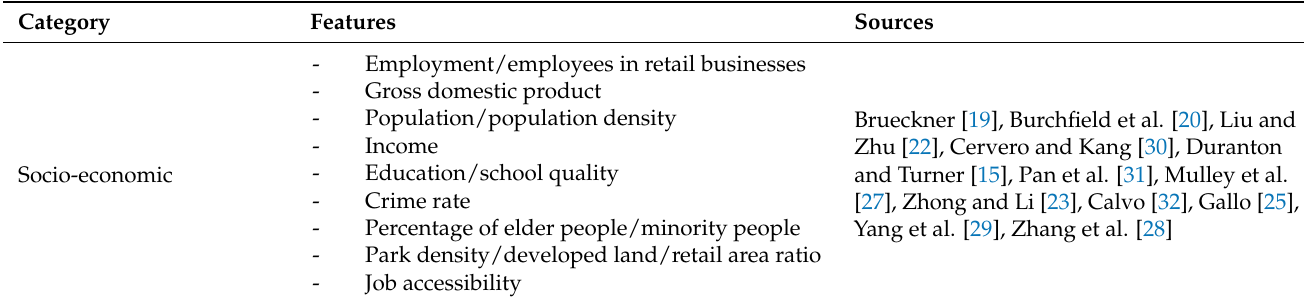
Table 1. Major features by categories in previous